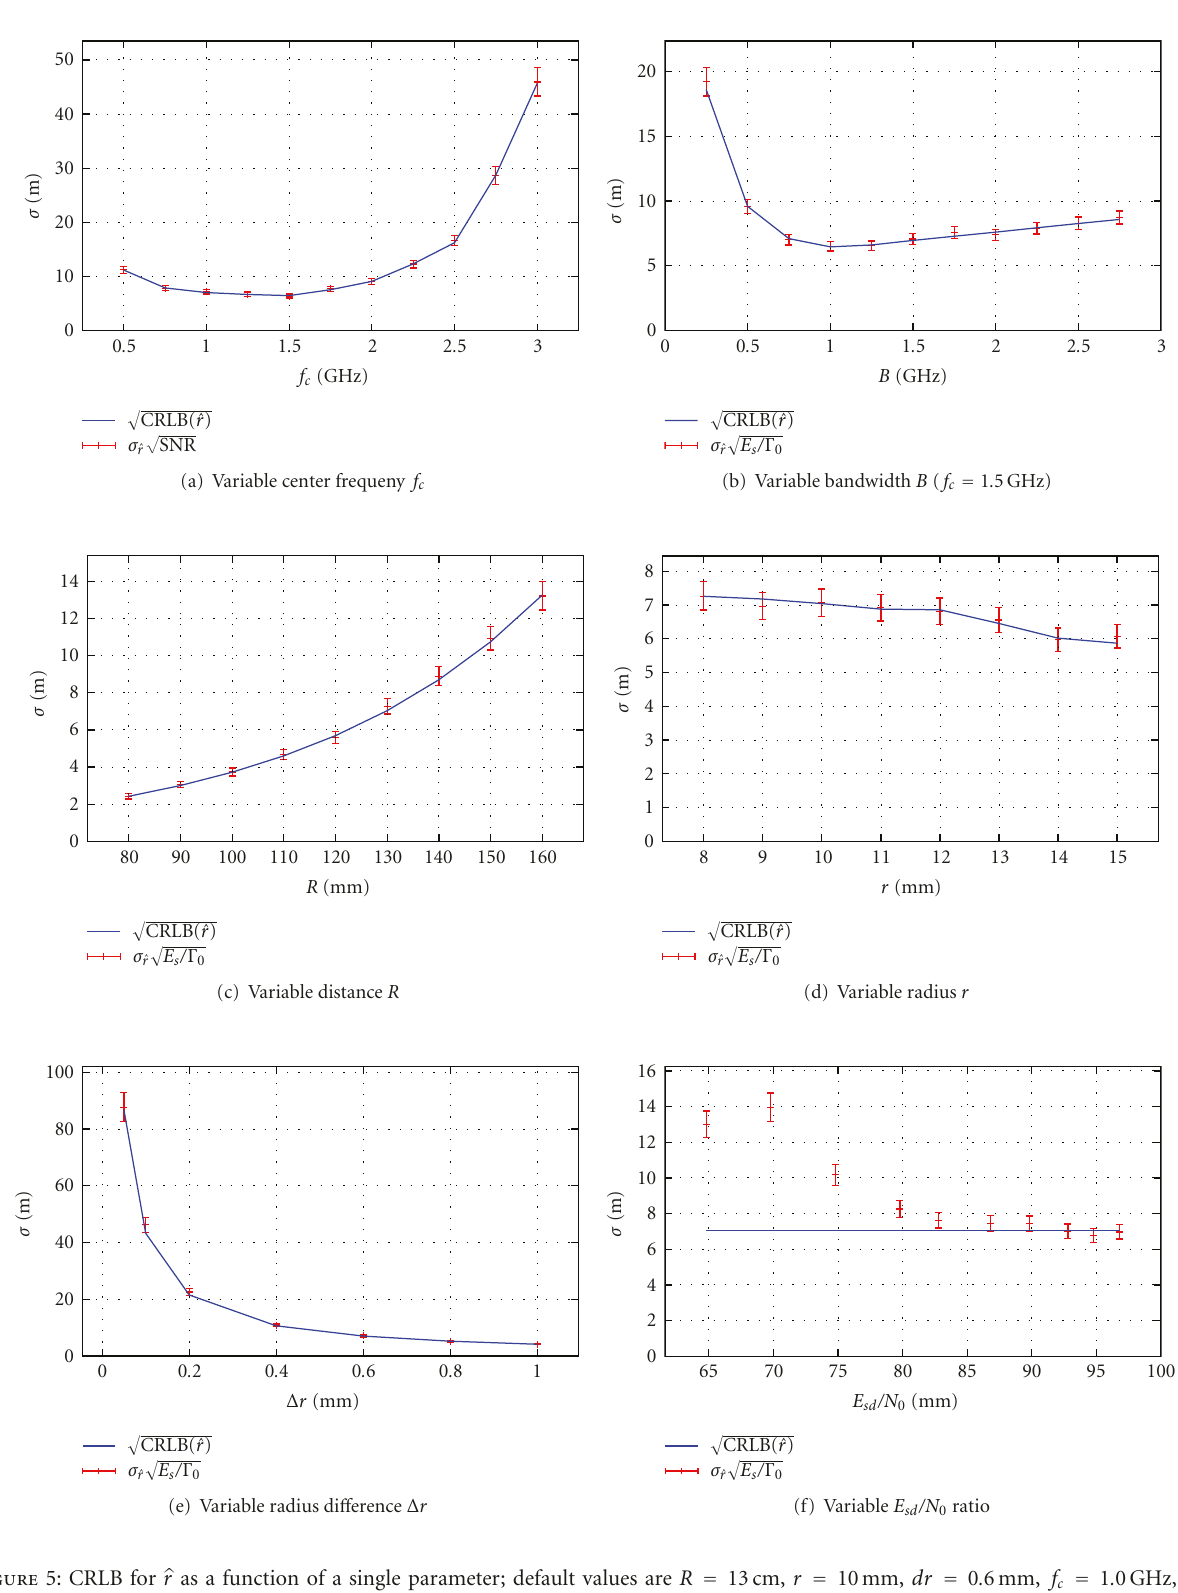
Figure 5: CRLB for (cid:3) r as a function of a single parameter; default values are R = 13cm, r = 10mm, dr = 0 . 6mm, f c = 1 . 0GHz, and B = 1 .